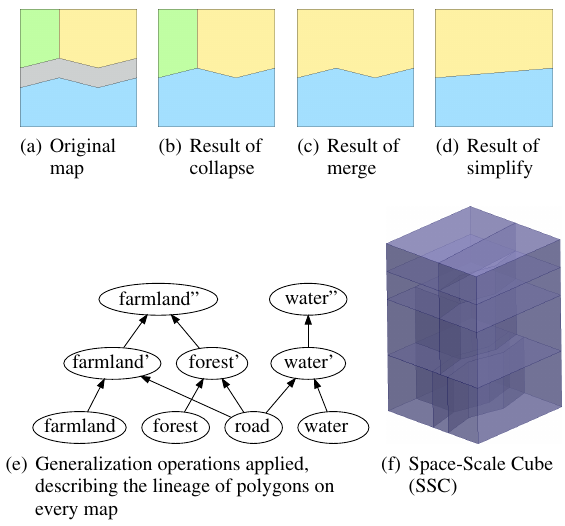
Figure 4: Illustration of generalization process and the resulting